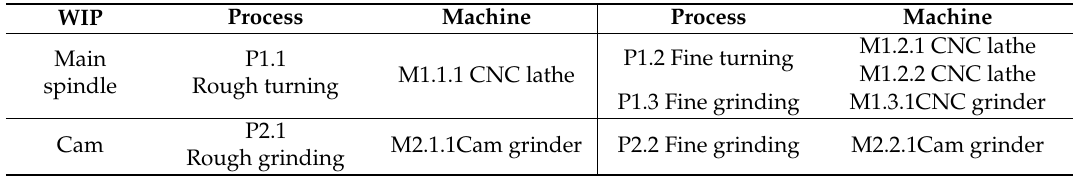
Table 1. Camshaft manufacturing processes and